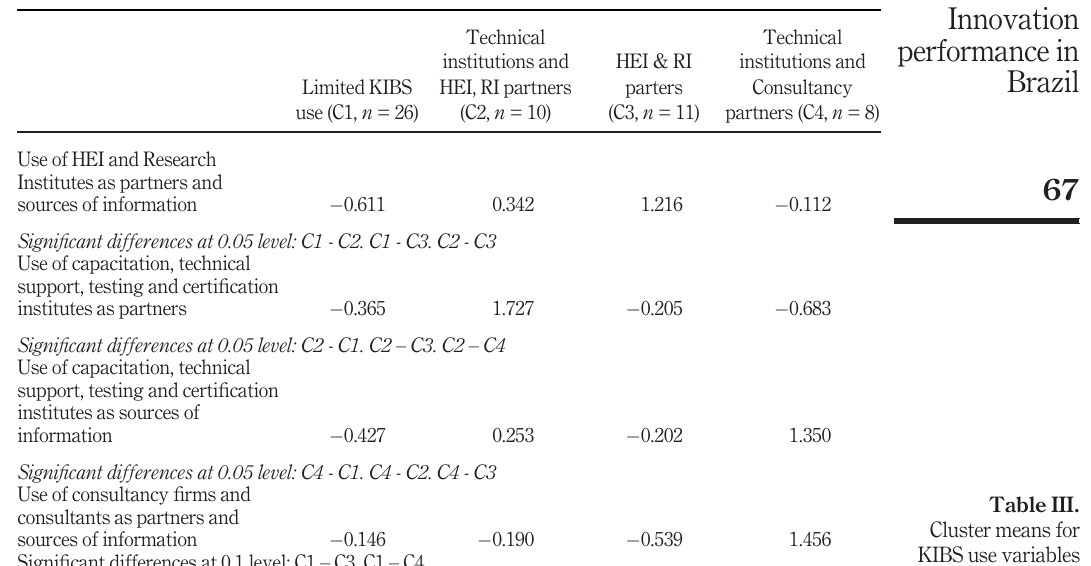
Table III. Cluster means